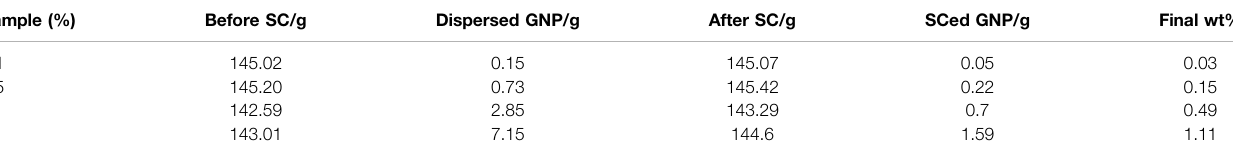
TABLE 2 | Weight of glass fabric before and after spray coating (SC), GNP dispersed in ethanol and fi nal amount spray-coated (SCed) onto fabric. Sample (%) Before SC/g Dispersed GNP/g After SC/g SCed GNP/g Final wt% 0.1 145.02 0.15 145.07 145.20 0.73